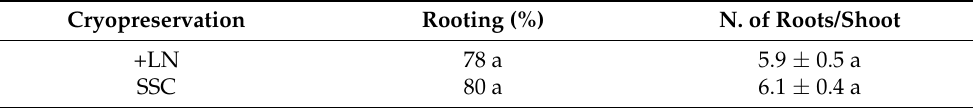
Table 2. Rooting of Corylus avellana , cultivated variety Tonda Gentile Romana, in cryopreserved (+LN) and in shoots grown in standard cultural conditions (SSC). Mean data are followed by Standard Error. Means on the column followed by the same letters are not significantly different ( p ≤ 0.05) according to Tukey’s